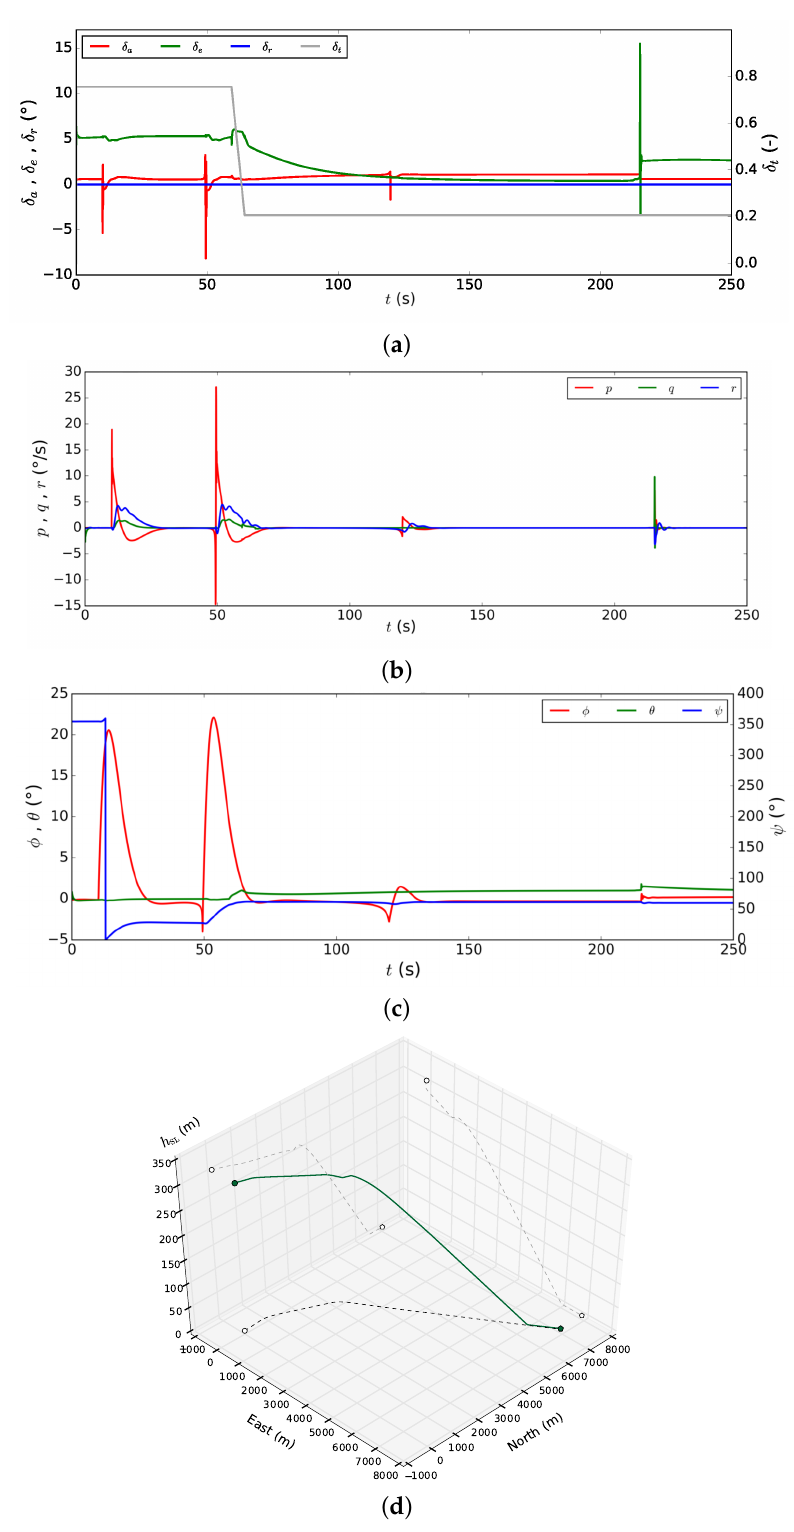
Figure 2. ( a ) time histories of the total actions on the aircraft four main control devices: (cid:4) aileron δ a , (cid:4) elevator δ (cid:4) rudder δ (cid:4) throttle δ e , r and t , on the right vertical axis. These are the superposition of the initial trim command and autopilots actions; ( b ) time histories of the angular speed components in body axes: (cid:4) roll rate p , (cid:4) pitch rate q and (cid:4) yaw rate r ; ( c ) time histories of the Euler angles: (cid:4) bank angle φ , (cid:4) elevation-angle θ and (cid:4) heading angle ψ on the right vertical axis; and ( d ) 3D representation of the trajectory, with ground track and side-view projections. Altitude is not to